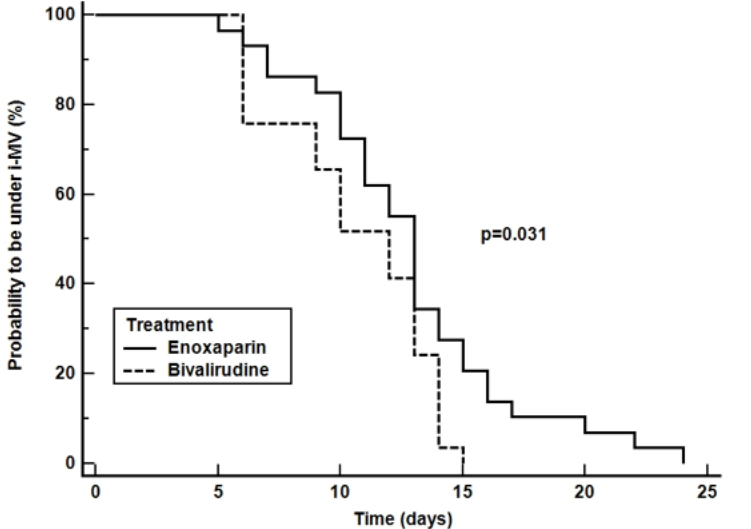
Figure 2. Probability to receive invasive mechanical ventilation during 28-day of follow-up. The curves depict the probability to receive invasive mechanical ventilation during 28-day of follow-up from randomization in patients receiving enoxaparin ( solid line ) or bivalirudin ( dashed line ).